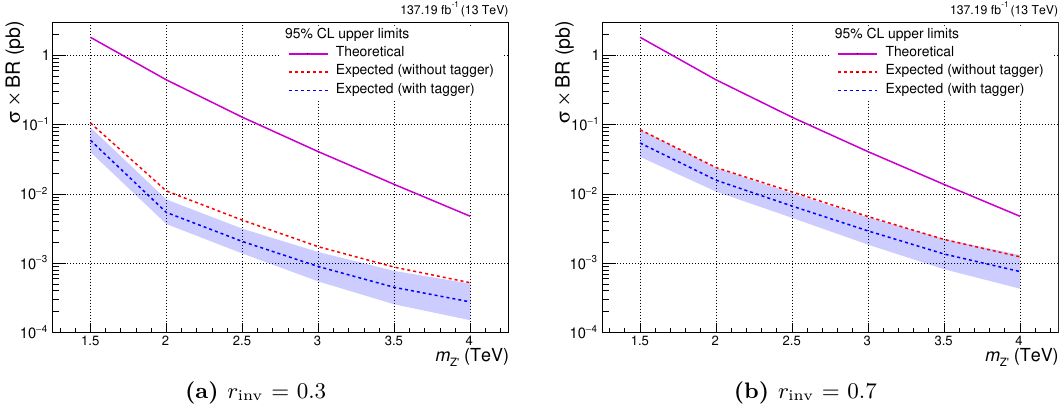
Figure 8. The cross section limits vs. m to the luminosity of the full Run 2 of the